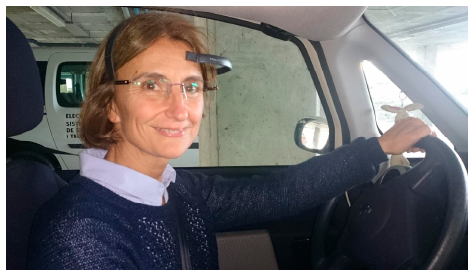
Figure 6. Participant with the EEG acquisition device.